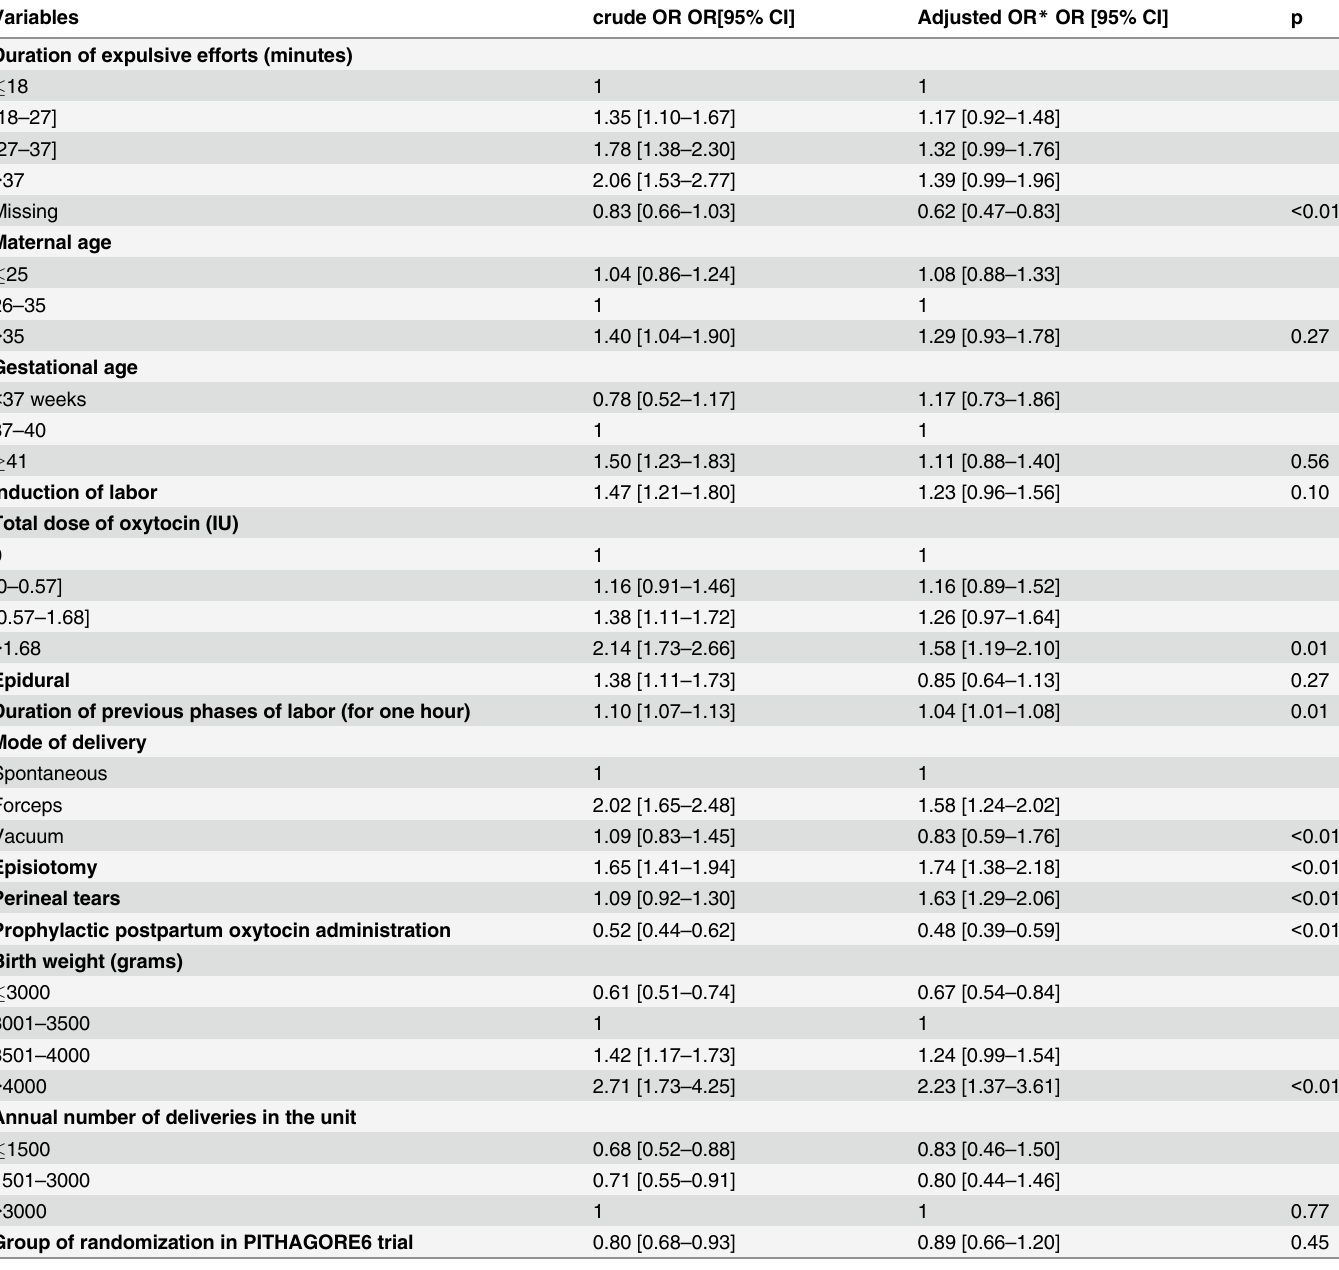
Table 3. Association between duration of expulsive efforts and risk of PPH – univariable and multivariable analyses (n = 4389; 3688 PPH and 701 controls).